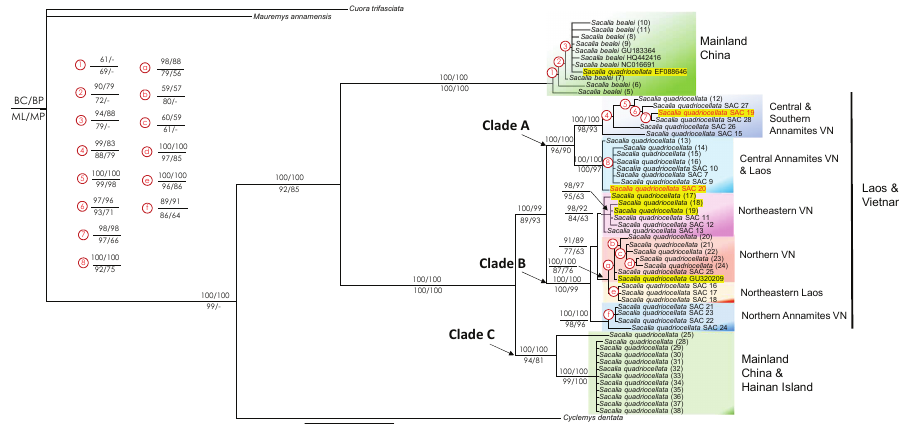
Figure 3. Bayesian cladogram, based on the complete mitochondrial cytochrome b gene. The numbers above and below branches are Bayesian posterior probability for single/multiple models and maximum likelihood/maximum parsimony bootstrap values, respectively (all in percentage). Highlighted samples in red and black letters denote those originating from confiscations and GenBank or the previous study with no reliable locality/identity,